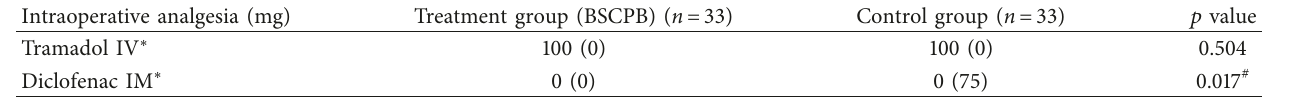
Table 3: Comparison of intraoperative total analgesia consumption between